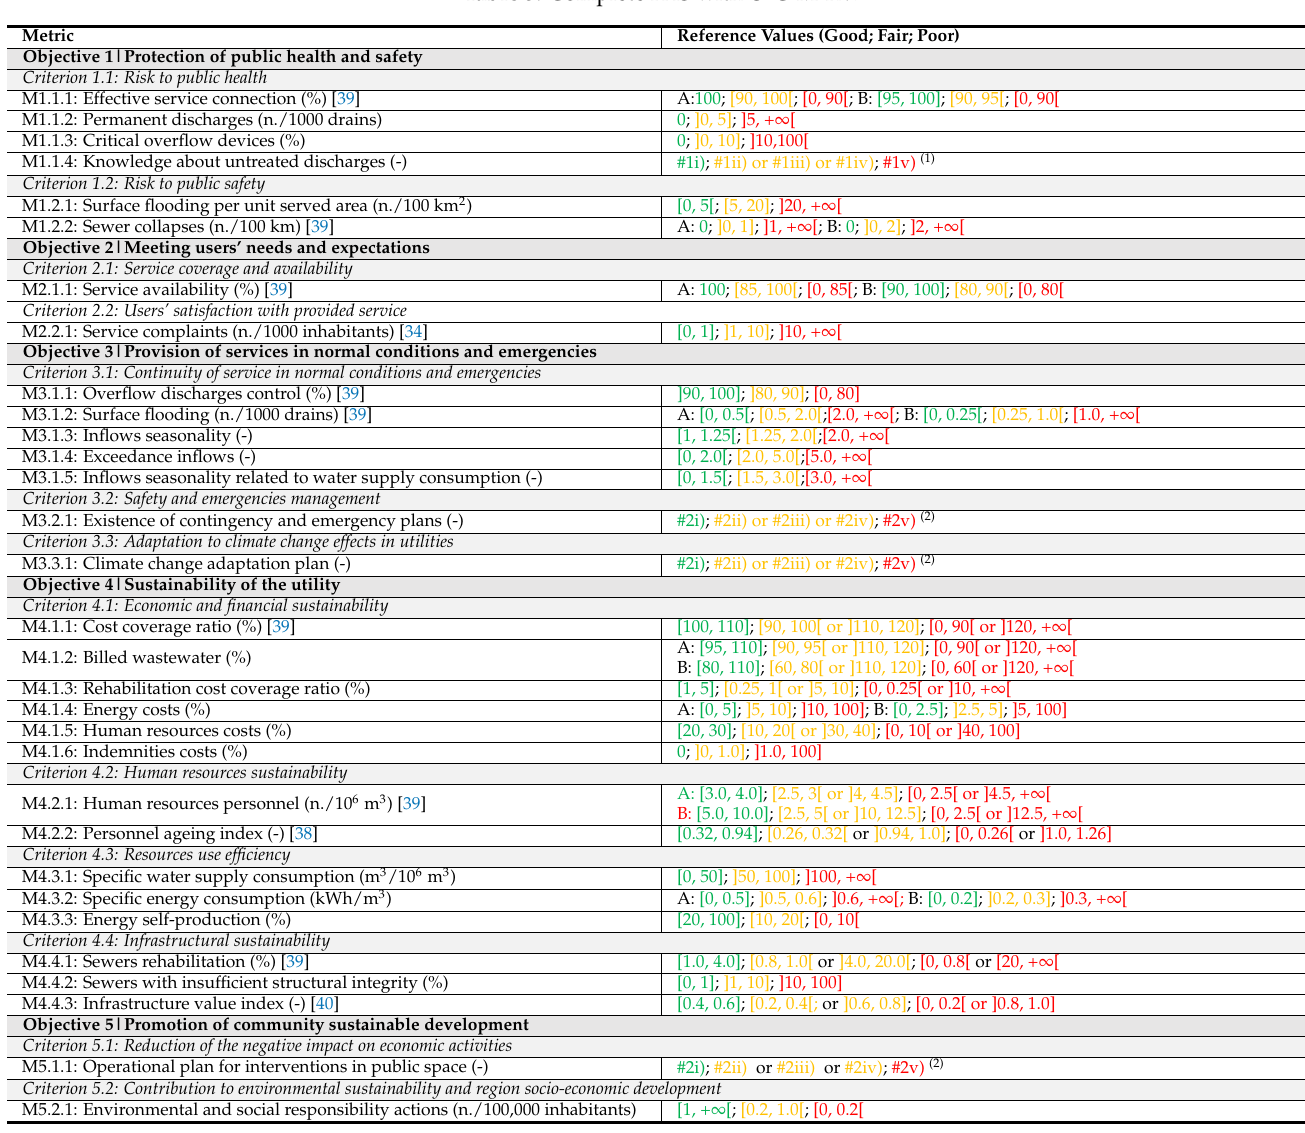
Table 5. Complete PAS with